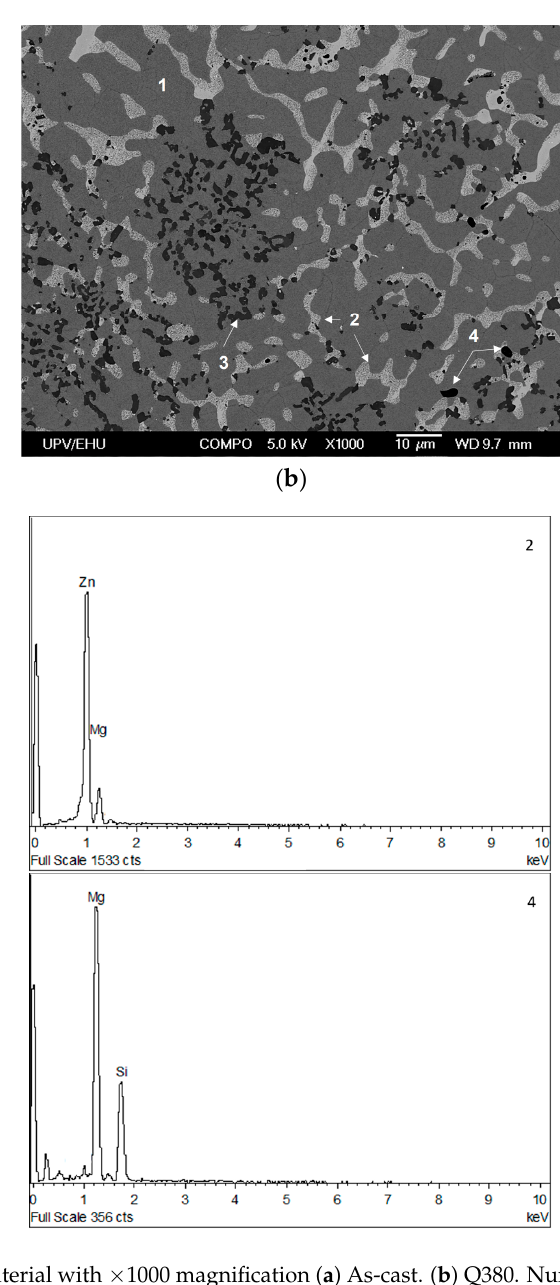
Figure 4. Thermodynamic simulations with FactSage for the studied alloy considering ( a ) equilibrium solidification conditions and ( b ) non-equilibrium solidification (Scheil model).